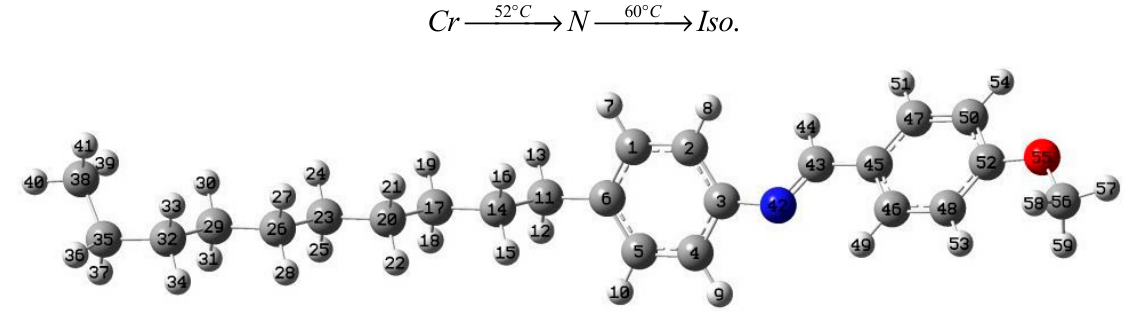
Figure 1. Optimized chemical structure of p -methoxybenzylidene p -decylaniline (MBDA).